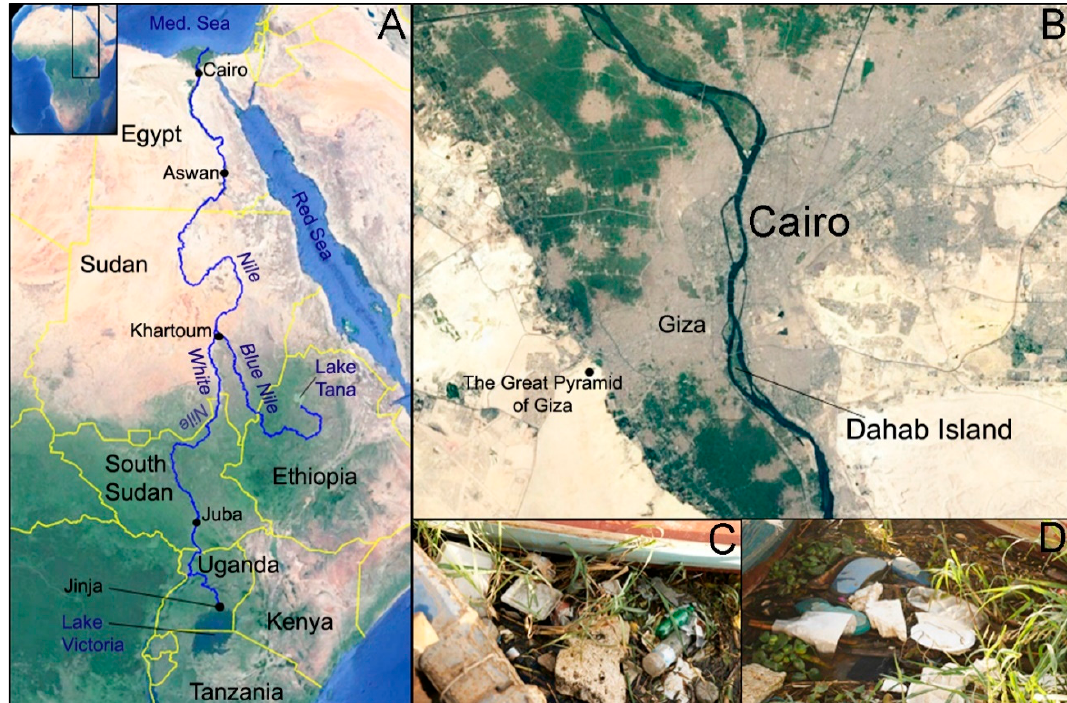
Figure 1. Path of the Nile River starting at Lake Tana (Blue Nile) and Lake Victoria (White Nile), respectively, before meeting at Khartoum and flowing toward the Mediterranean Sea via Cairo, the area of the present study ( A ). Fish were caught around Dahab Island in the Nile River at Cairo and purchased from markets located along the Nile Corniche on the east bank of the Nile opposite Dahab Island ( B ). Examples of plastic litter found close to Dahab Island and along the Nile ( C , D ). (Map source: Google Earth (2019) with the path of the Nile River overlaid from shapefiles [30]).